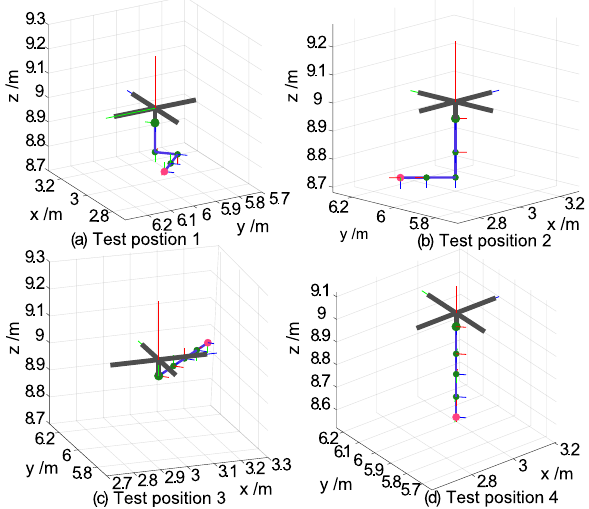
Figure 3. Illustration of 4 test positions of the